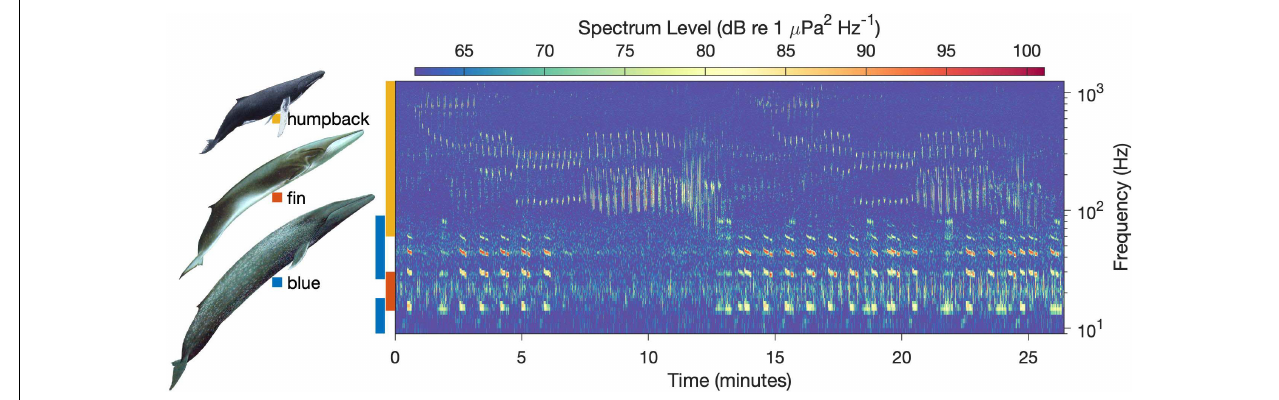
FIGURE 2 | Simultaneous song from three baleen whale species recorded in Monterey Bay National Marine Sanctuary. Spectrogram calculation used 12.8 kHz data (decimated from 256 kHz), 12,800 pt. FFT, Hanning window, 50% overlap; start time is 10-Jan-2017 13:33 UTC. Colored bars along the vertical axis define the approximate frequency ranges used by each species. Humpback song spans the greatest frequency range and is the most complex, with two full songs represented (beginning at ∼ 1 and 15 min). Blue whale song includes three call types: A calls—pulse-trains centered near 80 Hz, B calls—the loudest calls produced with fundamental frequency centered near 14.5 Hz and harmonics centered near 29, 43.5, and 58 Hz, and C calls—the subtlest of the three, centered near 11 Hz. Fin whale song is the simplest, consisting of brief ( ∼ 1 s) pulses that are modulated in frequency and variably paired in singlets, doublets, and triplets (Helble et al., 2020). Baleen whale song occurrence within the foraging habitat of MBNMS spans 7–9 months of the year, depending on the species (Ryan et al., 2019; Oestreich et al., 2020). Whale artist: Larry